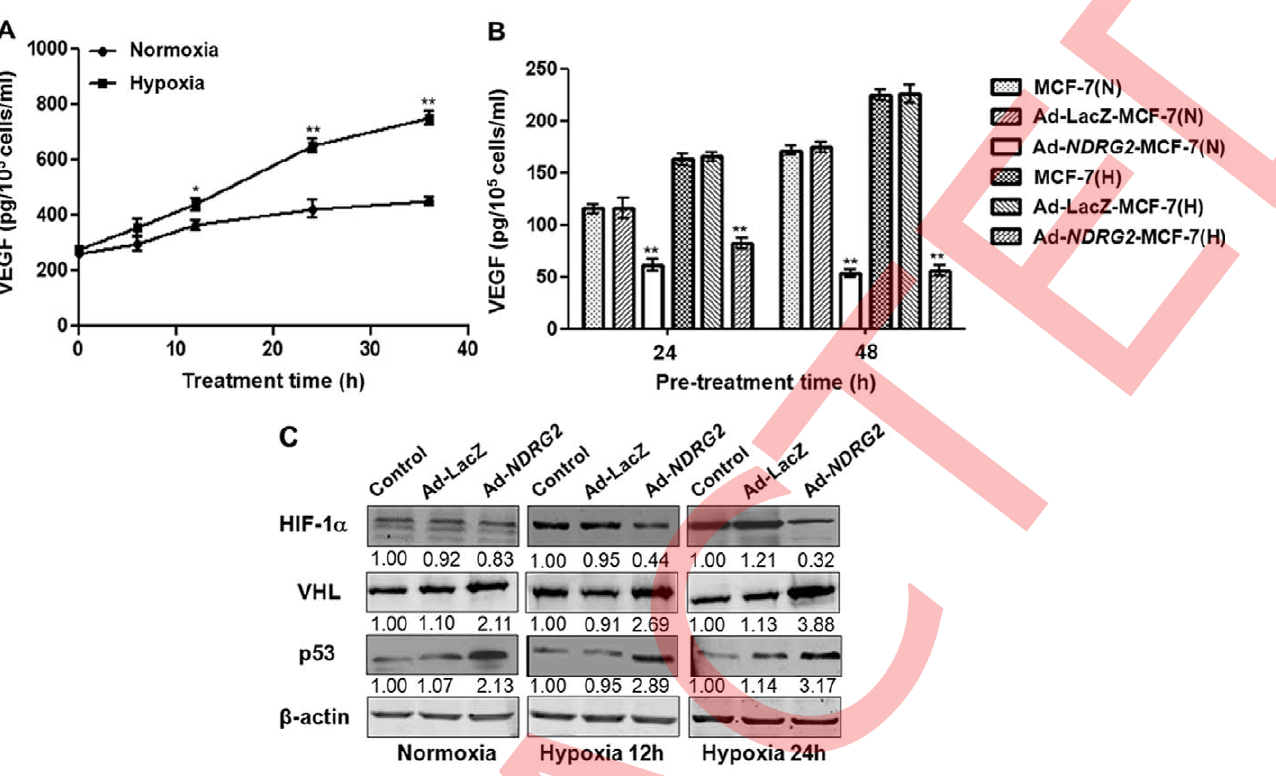
Figure 4. Effect of Ad- NDRG2 on the expression of VEGF, HIF-1 a , p53, and VHL under normoxia or hypoxia. (A) MCF-7 cells were incubated for the indicated time (0, 6, 12, 24, 36 h) in normoxic (21% O 2 ) or hypoxic (1% O 2 ) conditions. After incubation, the media were analyzed for VEGF levels by ELISA assay, and the cell number was counted. (B) MCF-7, Ad-LacZ-MCF-7 and Ad- NDRG2 -MCF-7 cells were incubated for the indicated time (24, 48 h) in normoxic or hypoxic conditions. After incubation, the media were analyzed for VEGF levels by ELISA assay, and the cell number was counted. The data are the mean 6 standard deviation (SD) for three independent experiments. Statistical significance was assessed with one-way ANOVA and Student’s t -test. * or ** indicates P , 0.05 or P , 0.01, respectively, when compared with the normoxia or Ad-LacZ-MCF-7 group. N, normoxia; H, hypoxia. (C) MCF-7, Ad-LacZ-MCF-7 and Ad- NDRG2 -MCF-7 cells were incubated under hypoxia for 0, 12, or 24 h. After incubation, the cells were analyzed by western blot assay. b -actin protein levels were used as a loading